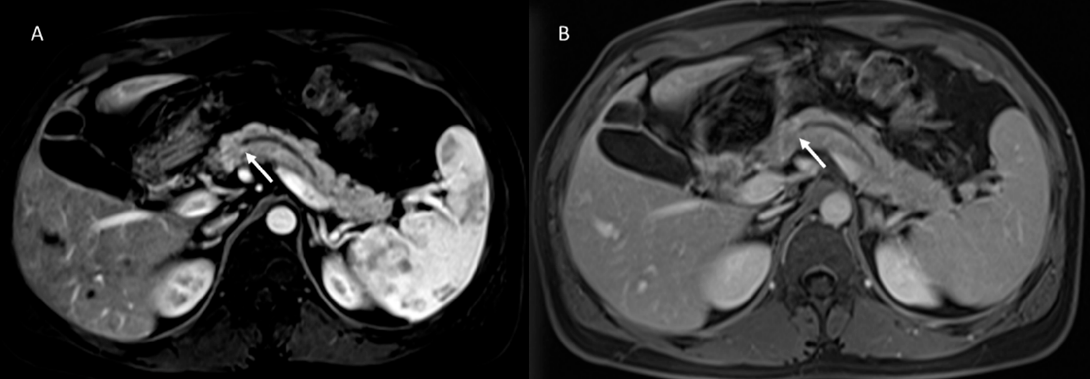
Figure 3. The same patient as in Figure 2; post-contrast MRI evaluation. In arterial ( A ) and portal ( B ) phase of contrast study, arrows show no tissue but dilatation of the main and secondary branch ducts.